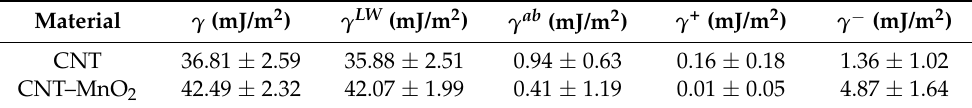
Table 3. Surface energy components of CNT and CNT–MnO 2 calculated according to the acid–base model.